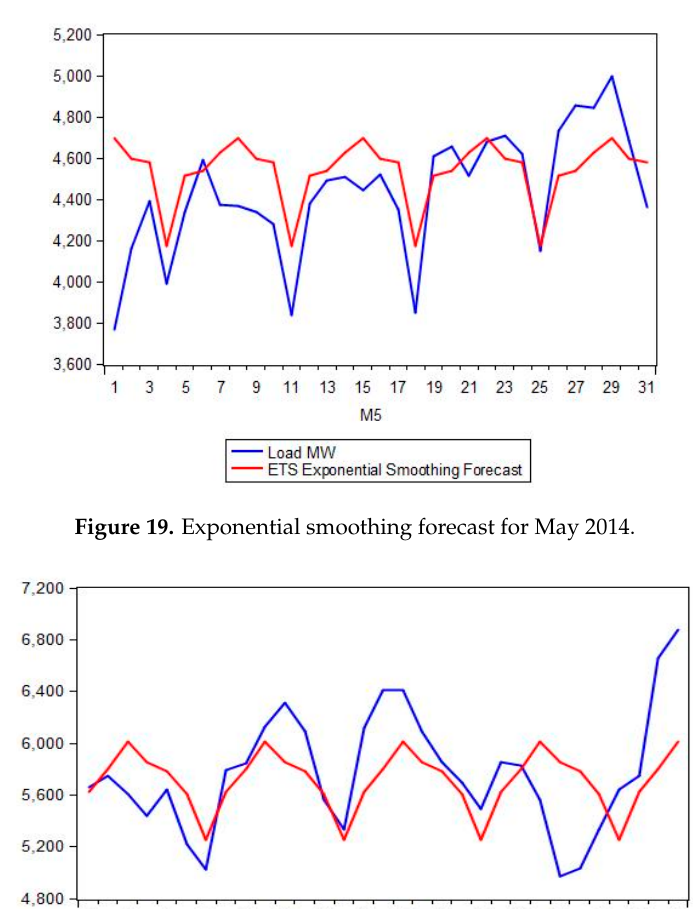
Table 10. Average errors per month for the time period 2004–2014 & length of estimation set for each